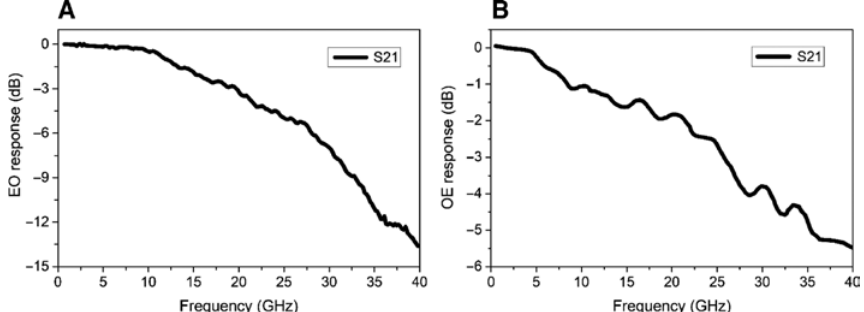
Figure 7: The electro-optic bandwidth characterization of microring modulator and photodetector. (A) Microring modulator and (B)